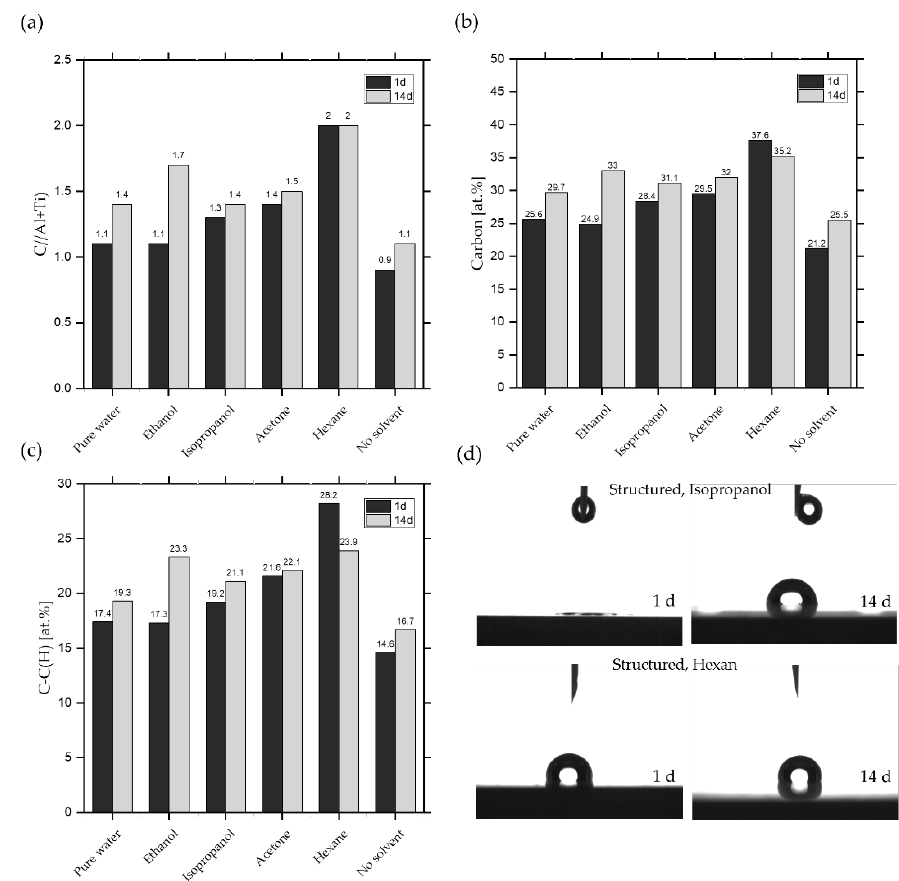
Figure 6. Comparison of the carbon content for structured surfaces and exemplary images of dispensed droplets for 1 and 14 days of storage. Structured surfaces are cleaned with different solvents and depicted in comparison to the uncleaned structured surface. XPS data are shown for the ( a ) atomic ratio C/(Al + Ti), ( b ) atomic total carbon content and ( c ) atomic amount of C – C(H) groups. Exemplary images of dispensed droplets on a structured surface cleaned in isopropanol and hexane for 1 and 14 days are shown in ( d ), respectively.